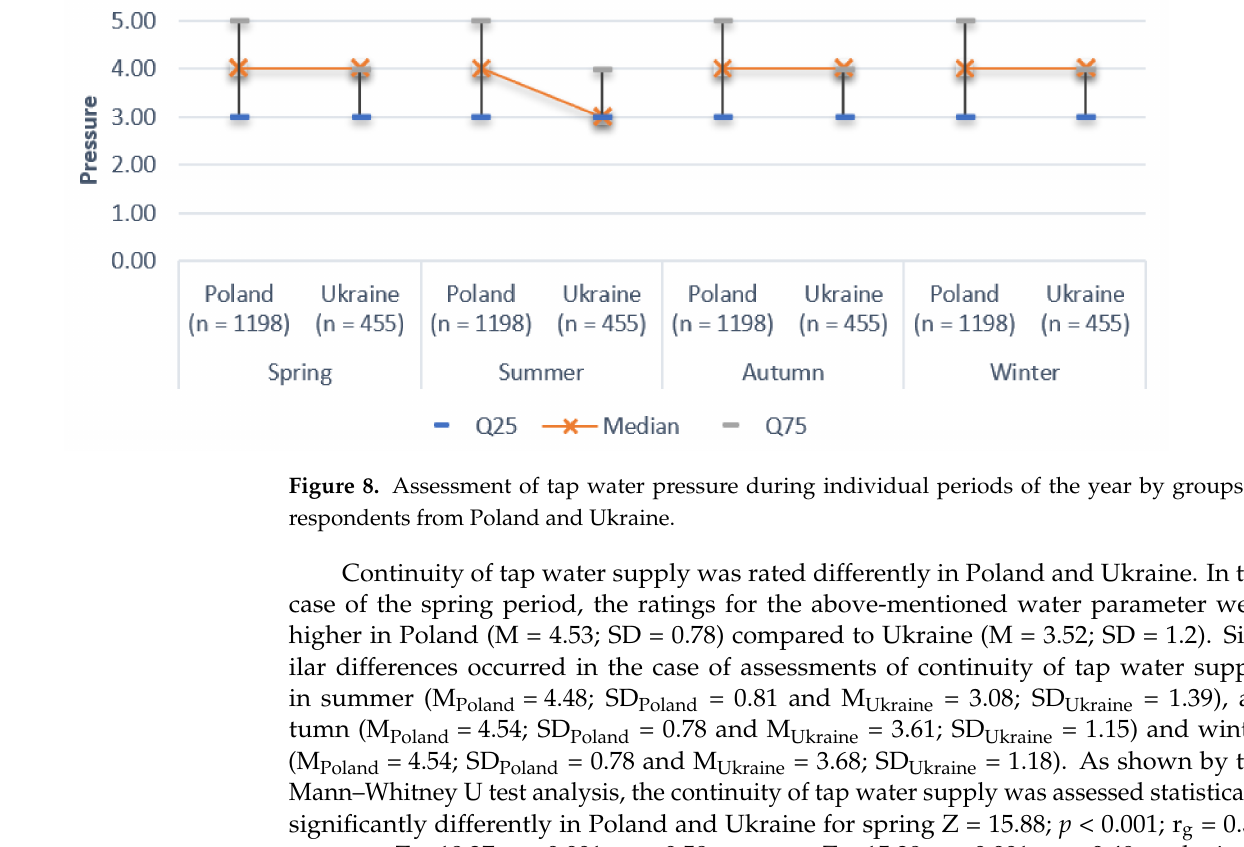
Table 14. Comparison of the groups of respondents from Poland and Ukraine in terms of evaluation of continuity of tap water supply during individual periods of the year. Descriptive Statistics—Continuity of Supply Confidence Interval GlassMean ± Min.– Stand. Dev. Max.